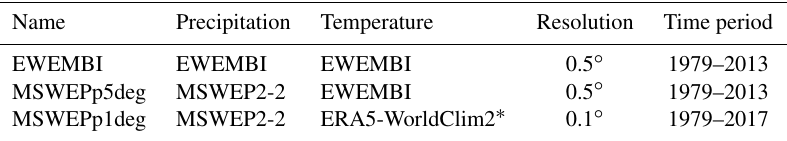
Table 1. List of meteorological forcing data sets used.